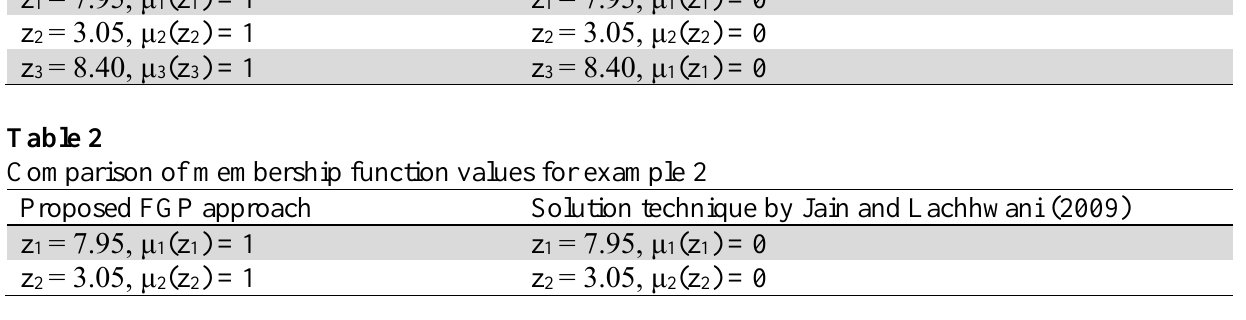
Comparison of membership function values for example 1 Proposed FGP approach